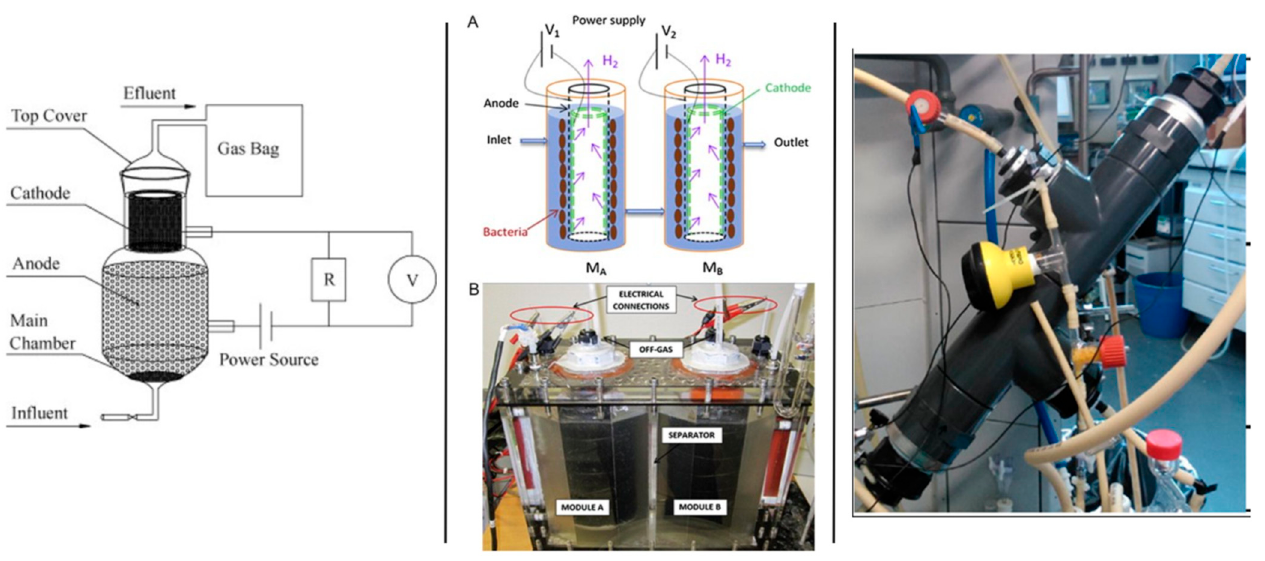
Figure 7. ( Left ) Schematic of the cathode-on-top single-chamber of the bioelectrochemical system [112]. ( Middle ) Pictorial view of semi-pilot tubular [A: Schematic view; B: Photographic view] [117]. ( Right ) Small scale tubular reactor for microbial electrosynthesis [30]. Reprinted with permission from Elsevier.